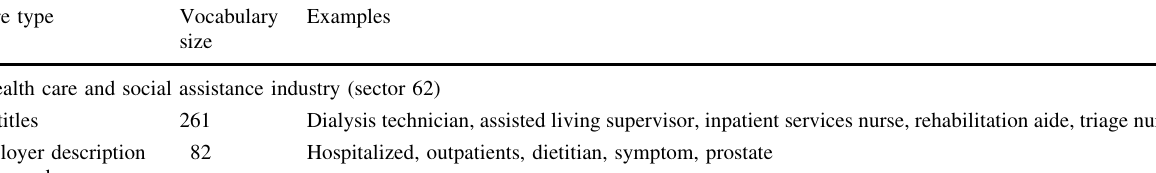
Table 2 Top job titles, employer description keywords, and company name keywords for three industries Feature